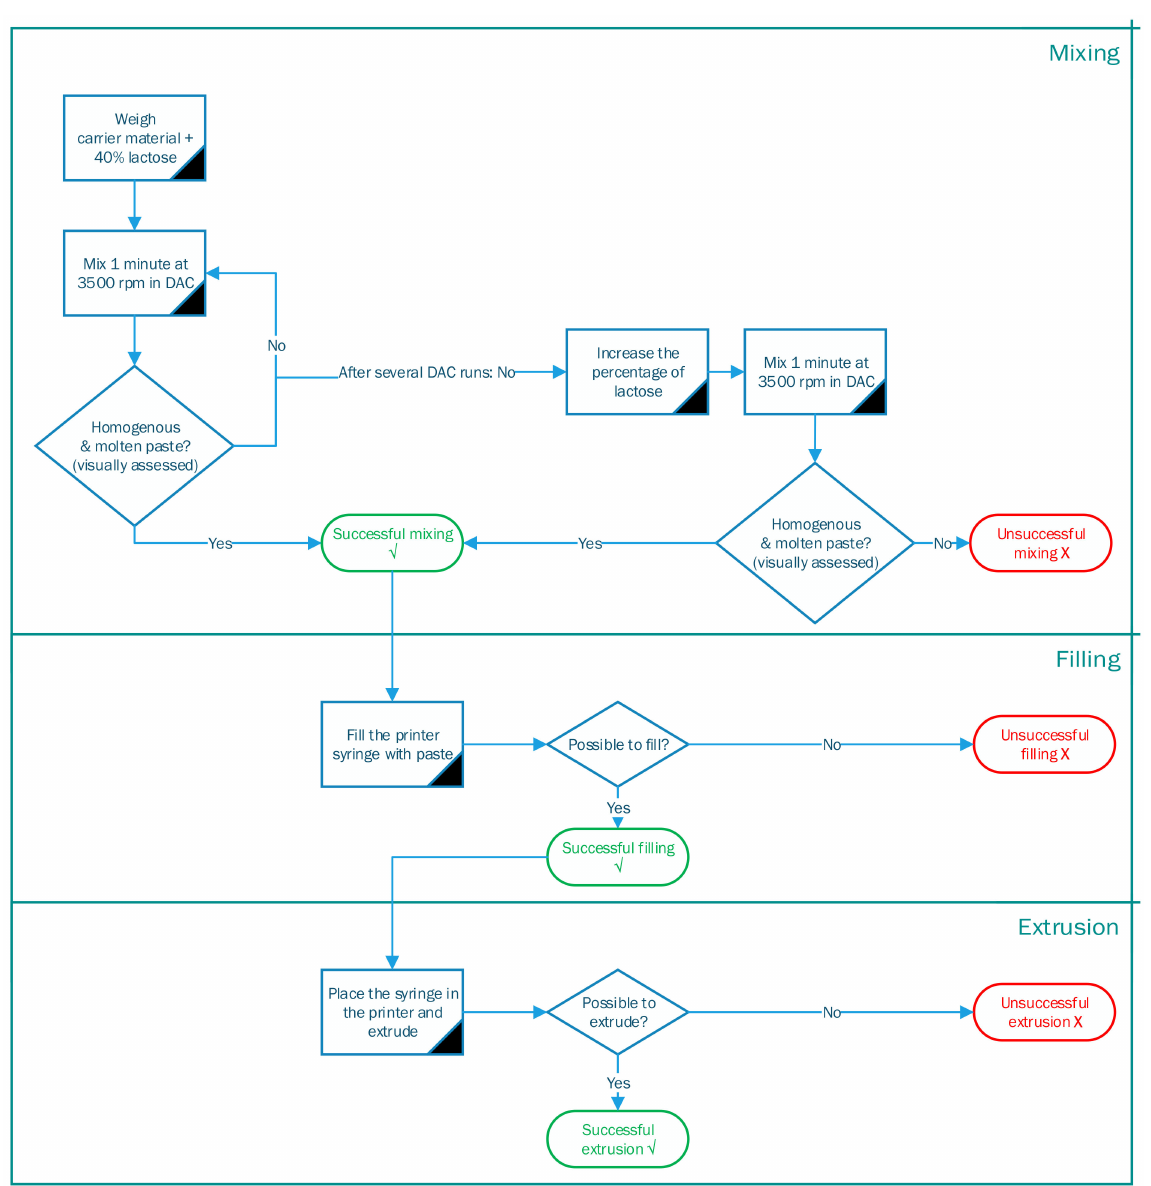
Figure 1. Decision tree of different processing steps for SSE 3D